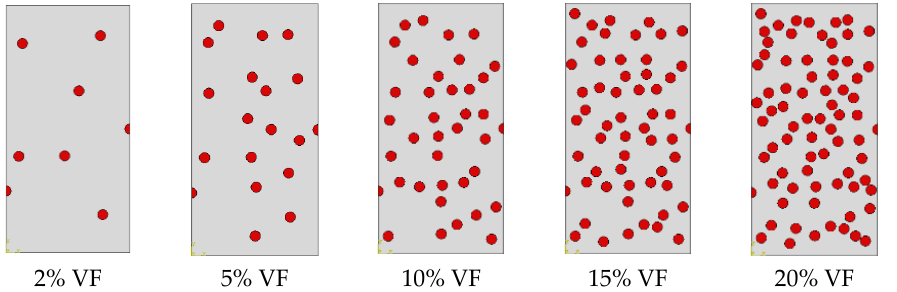
Figure 4. Representation of microstructure of A359 alloy matrix and SiC particles with various VFs (PS= 10 µm).